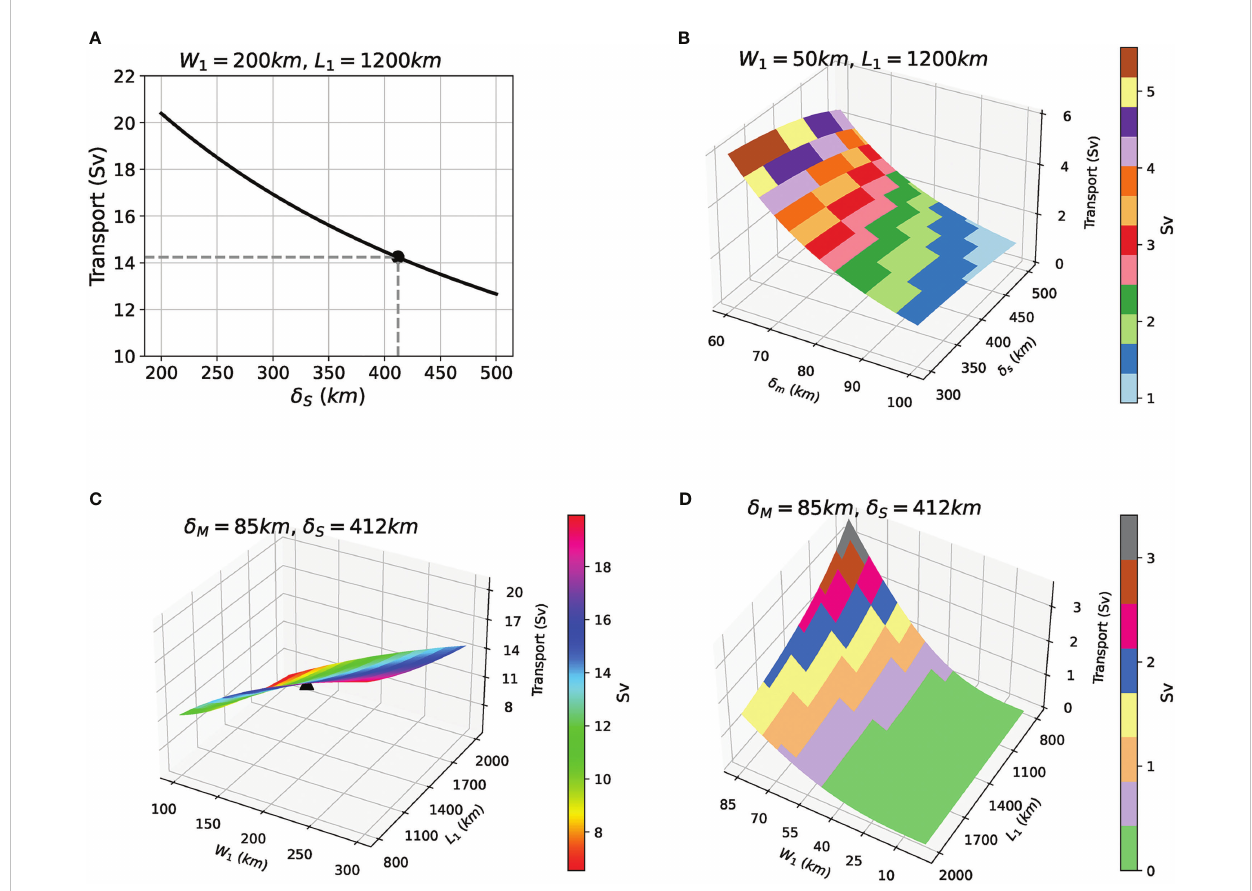
FIGURE 10 The idealized ITF transport as a function of various factors: thickness of Stommel boundary layer (A) , thickness of both Munk and Stommel boundary layers (B) , and channel size (C, D) . The horizontal coordinates corresponding to the dot marks in (A) and the triangular marks in (C) are the parameters used in the estimation of ITF in this